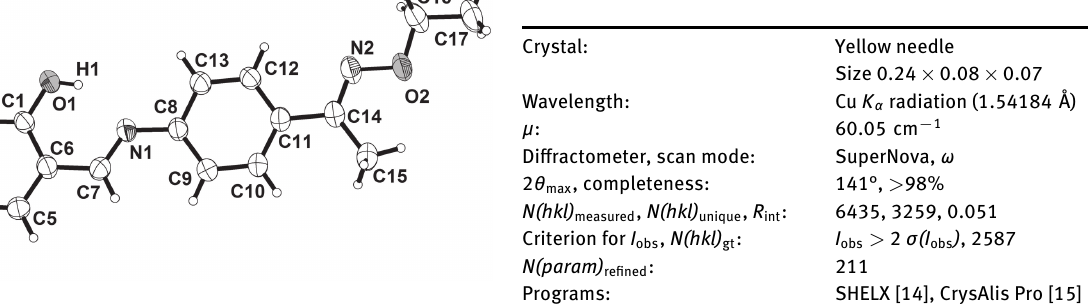
Table 1: Data collection and